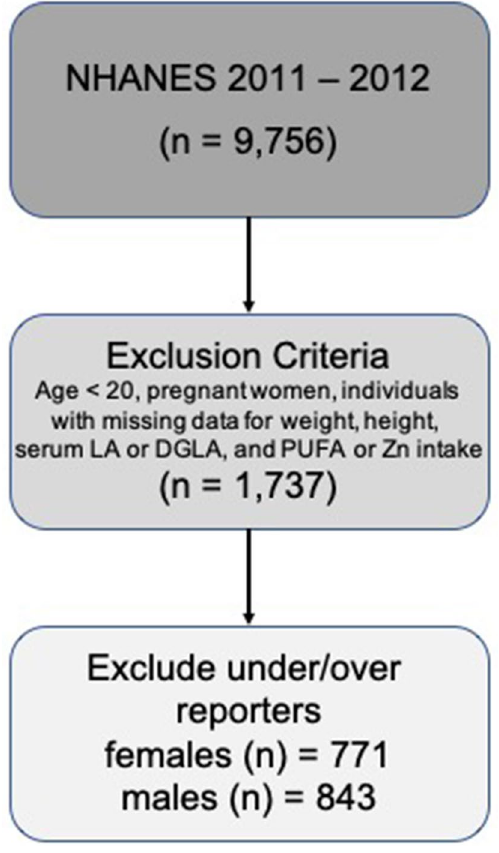
Figure 1. Flow diagram for the selection of the participants in the study from NHANES